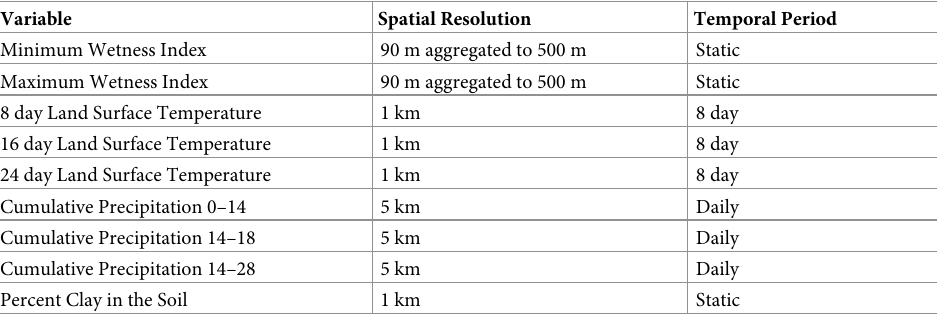
Table 1. Environmental variables included in candidate